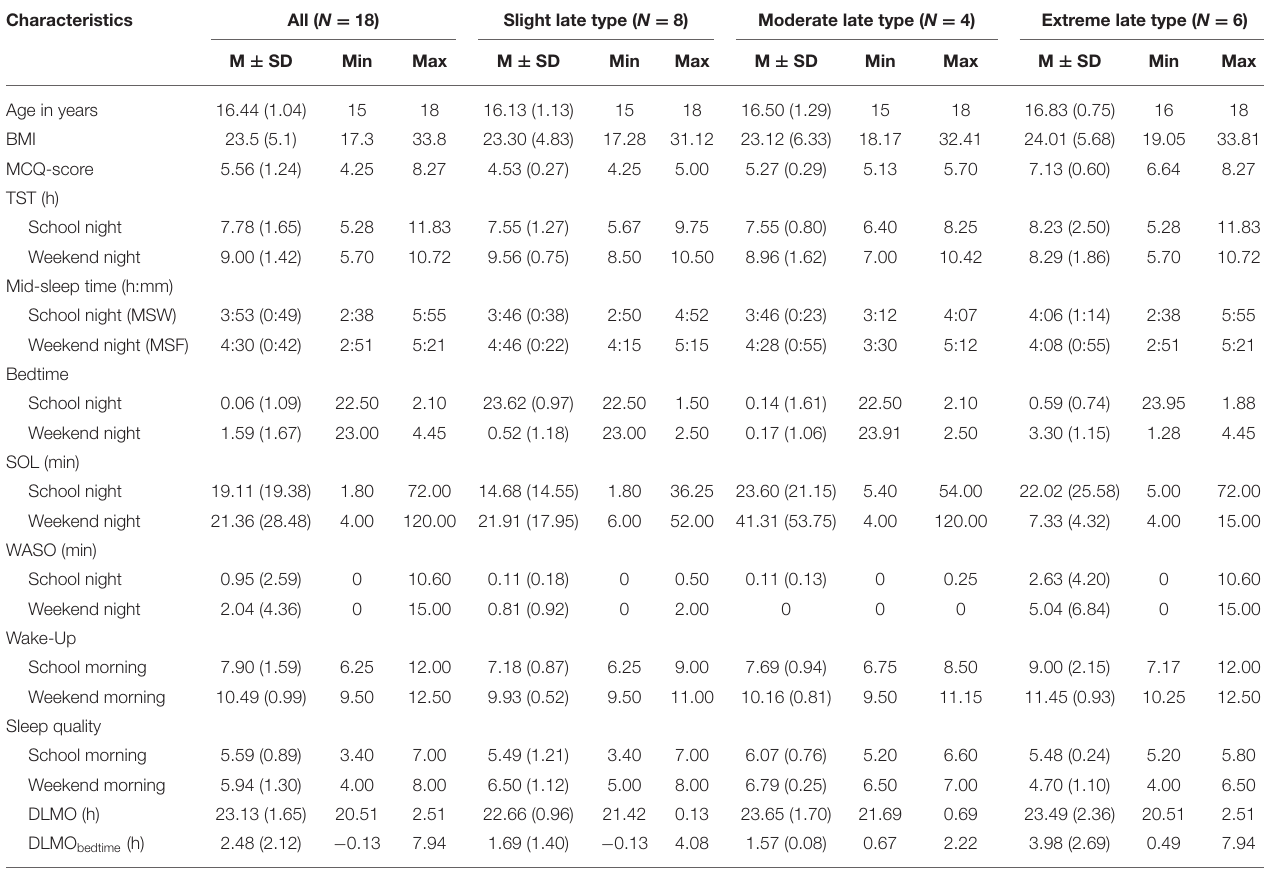
TABLE 1 | Descriptive statistics for sleep and circadian measures in chronotype subgroups.